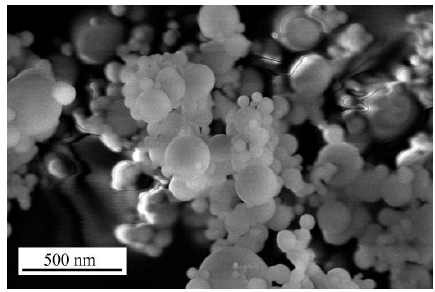
Figure 2. SEM image of the microsilica particles in µm.